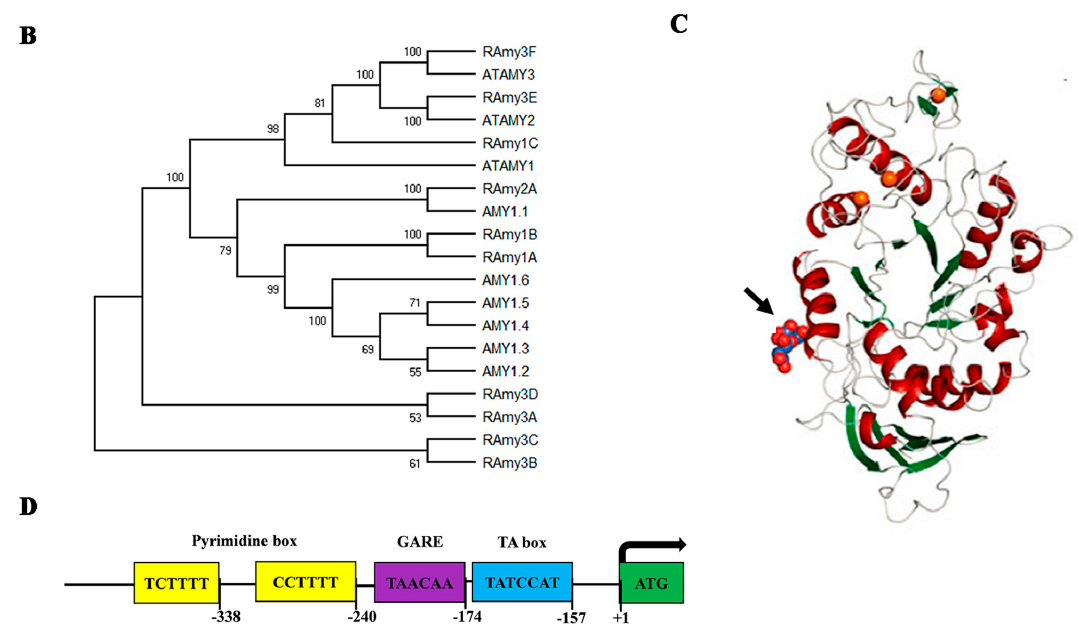
Figure 2. ( A ) Gene structure of the 10 rice alpha-amylase genes. ( B ) Phylogenetic relationship between alpha-amylase isozymes in rice, barley (AMY1.1-AMY1.6), and Arabidopsis (ATAMY(1,2 and 3)) by the Neighbor joining method drawn using MEGA version X [56]. The genomic and protein sequences were obtained from the Rice Genome Annotation Project using LOC_Os02g52700, LOC_Os02g52710, LOC_Os01g25510, LOC_Os06g49970, LOC_Os09g28400, LOC_Os09g28420, LOC_Os08g36900, LOC_Os08g36910, LOC_Os04g33040, and LOC_Os01g51754 [64] for RAmy1A , RAmy1B , RAmy1C , RAmy2A , RAmy3A , RAmy3B , RAmy3C , RAmy3D , RAmy3E , and RAmy3F , respectively. The barley gene ID that was used for downloading the sequences was obtained from [64] and the sequences were downloaded from NCBI. For Arabidopsis, the sequences were downloaded from TAIR. ( C ) The overall crystal structure of Amy1A. Calcium ions are represented as orange balls, secondary carbohydrate binding site (SBS1 indicated by the black arrow) comprising of oxygen atoms (red balls) and carbon atoms (deep blue shape), (cited from [57]) ( D ) Schemes of Constructs for the representative promoter of Amy1A .